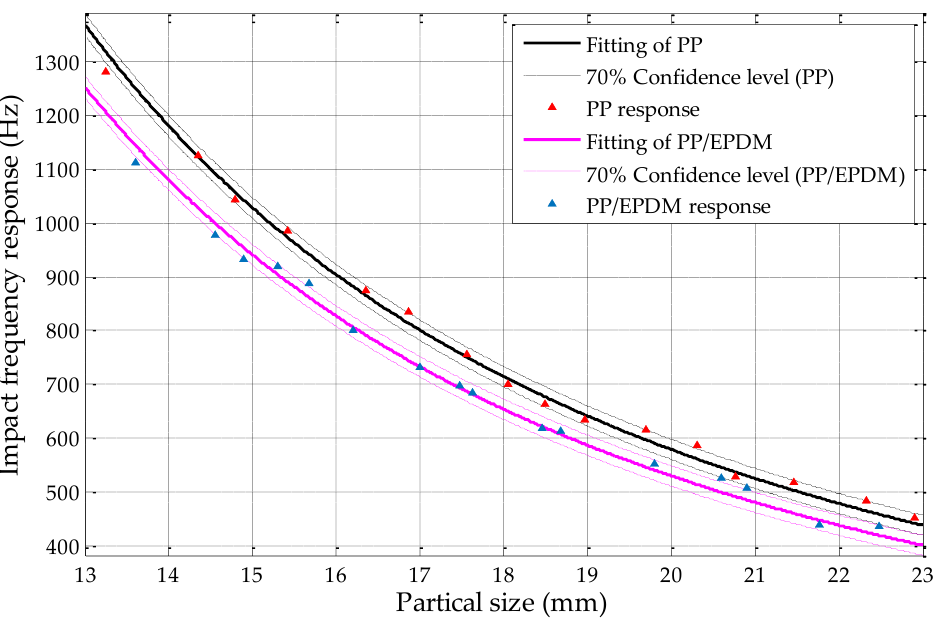
Figure 18. The 70% confidence level of the PP and PP/EPDM mixture by using circularity measurements.